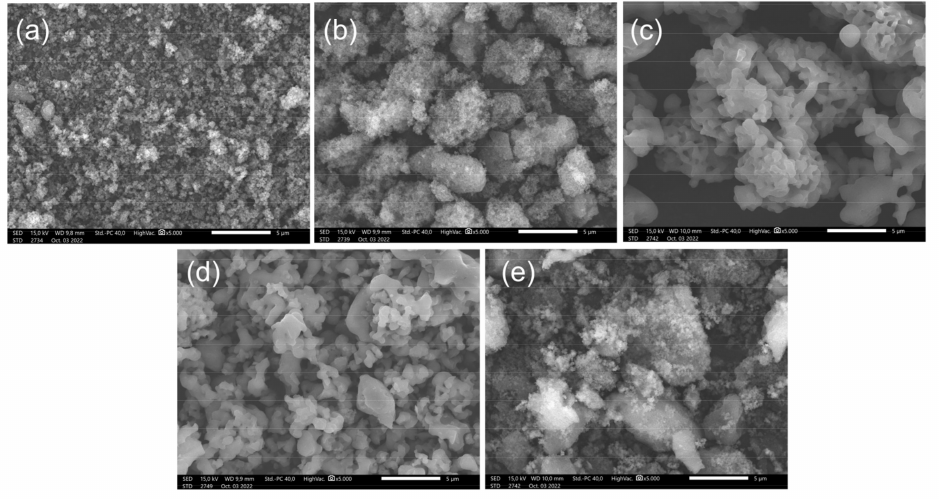
Figure 3. SEM micrographs of ( a ) SiO 2 ( b ) SiO 2 /Zr ( c ) SiO 2 -TEDTA ( d ) SiO 2 /Zr-TEDTA and ( e ) SiO 2 /Zr-CEDTA.